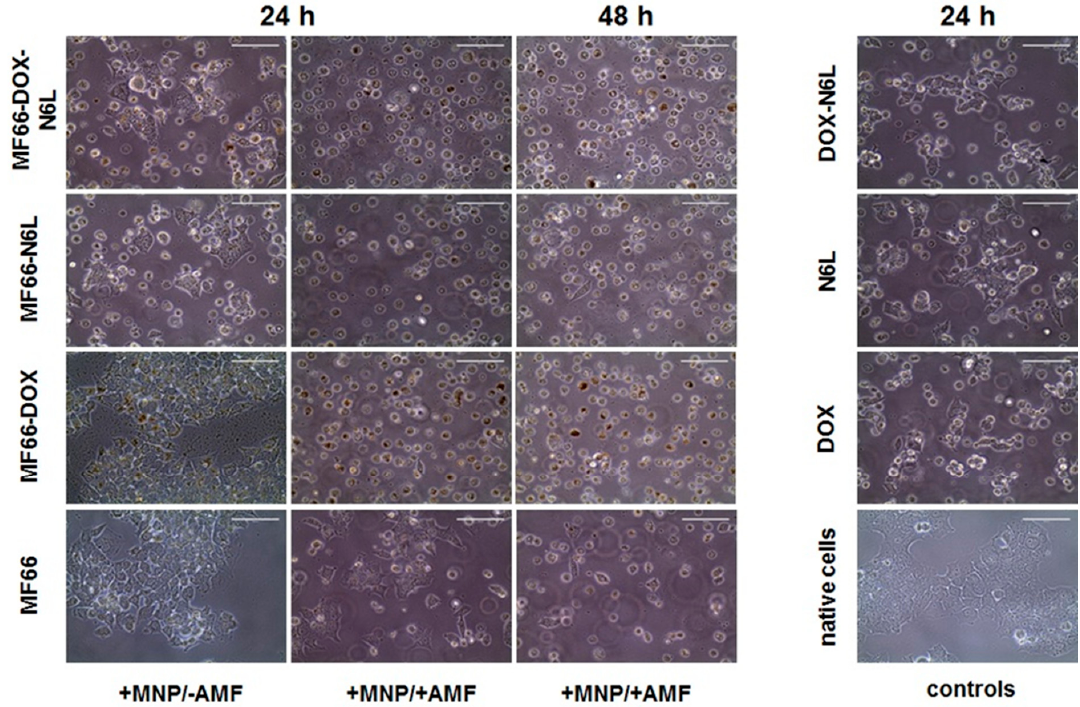
Figure 6. Magnetic hyperthermia in combination with ((DOX and/or N6L) MNP formulations induced morphological changes and detachment of BT474 cells. Representative microscopic images of BT474 cells, which were incubated with the different MF66 formulations (100 µg Fe/mL, 24 h); 24 h or 48 h post magnetic hyperthermia (+MNPs/+AMF), MNPs control (+MNPs/ − AMF), free agent controls (DOX, N6L or both) as well as untreated controls (native BT474). Scale bar = 100 µm.